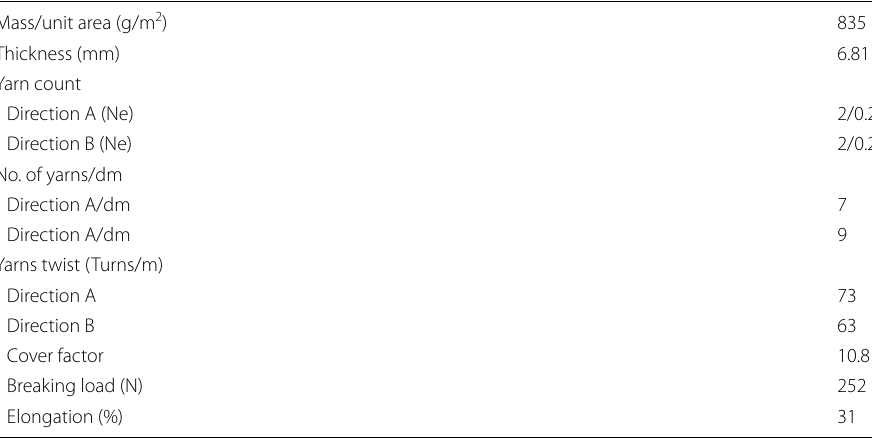
Table 2 Mechanical properties of coir mat